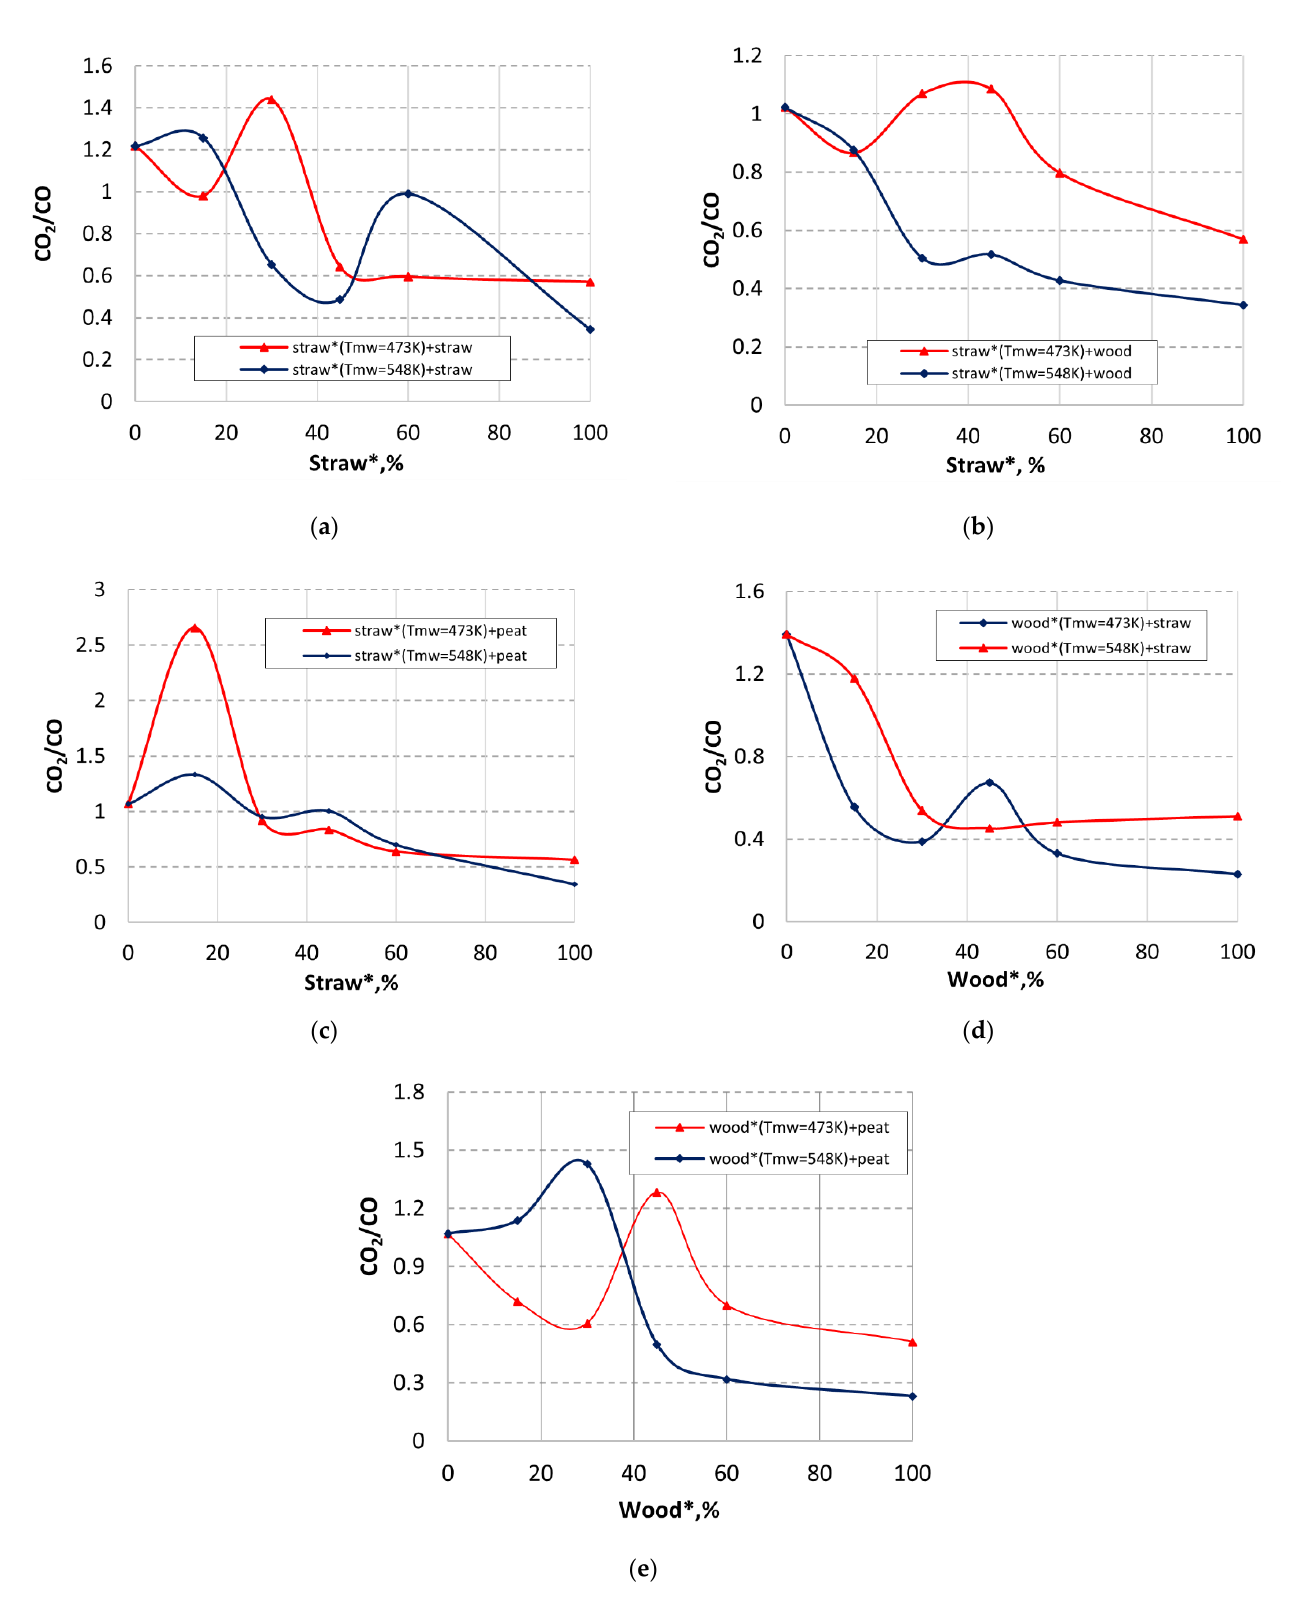
Figure 5. The effect of MW pre-treatment temperature and mass fraction of pre-treated pellets in the blend on the yield of combustible volatiles (CO, H 2 ) ( a – e ) and summary of the yield of CO all blends ( f ) (for composition of blends see Figure 4).